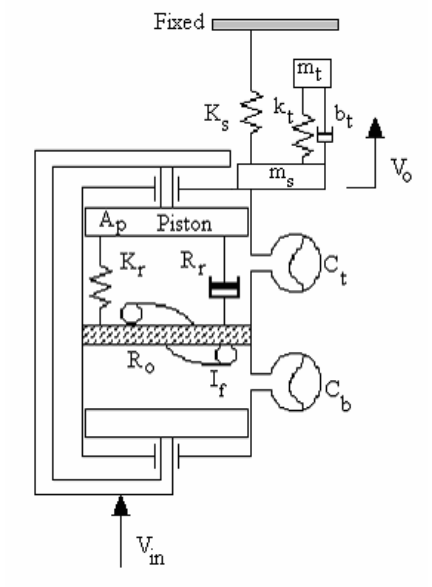
Fig. 8. Physical model considered for this